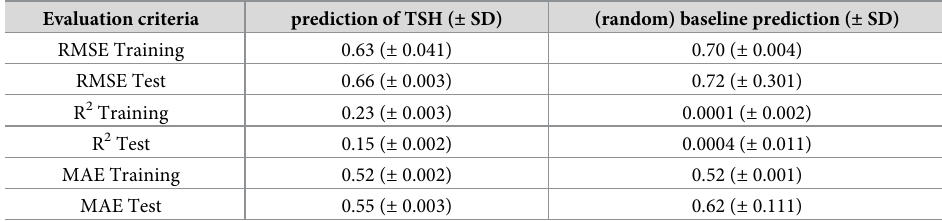
Table 3. Evaluation of the final RF model for the prediction of TSH. As a baseline comparison, we trained a similar model on the same dataset where TSH values have been randomly shuffled. The scores given in the column (random) baseline prediction thus represent scores achieved by random guessing. Average results are presented together with standard deviations given in